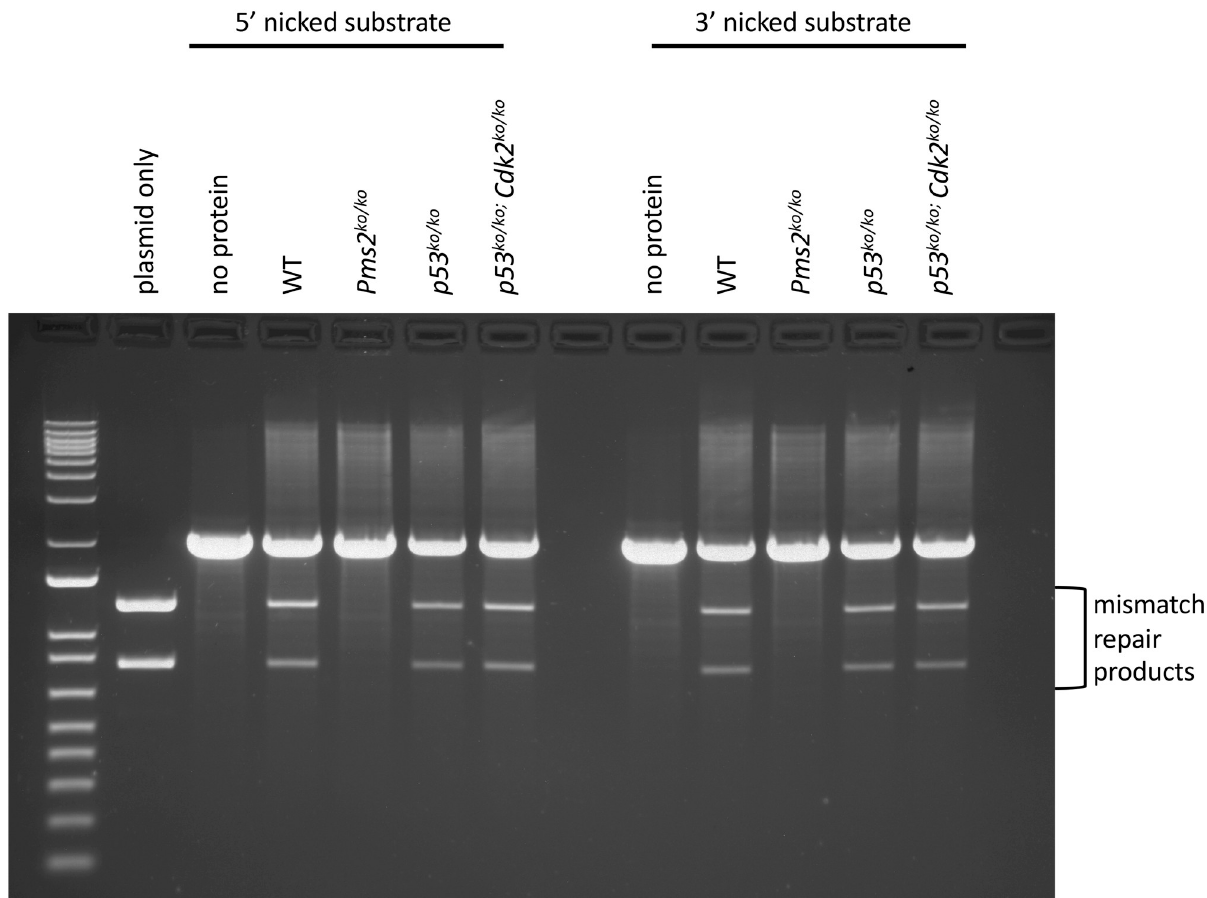
Fig 4. Endonuclease activity of PMS2. The endonuclease activity of PMS was measured in vitro using nuclear extracts from p53 ko/ko ; Cdk2 ko/ko , p53 ko/ko , Pms2 ko/ko , and wild type (WT) MEFs. Heteroduplexes with either a 5’ or a 3’ nick were digested with AseI and PstI after incubation with nuclear extracts. Products of the digestions were run on agarose gels. The endonuclease activity of PMS2 leads to repair at the PstI site resulting in a 0.8kb and 1.2kb fragment. The far left lane shows a molecular weight marker. Controls included “plasmid only” and “no protein”.